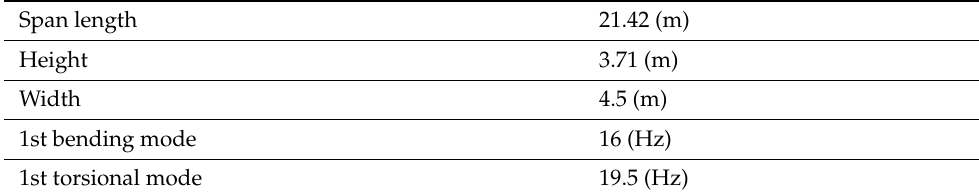
Table 2. Span dimensions and natural frequencies.